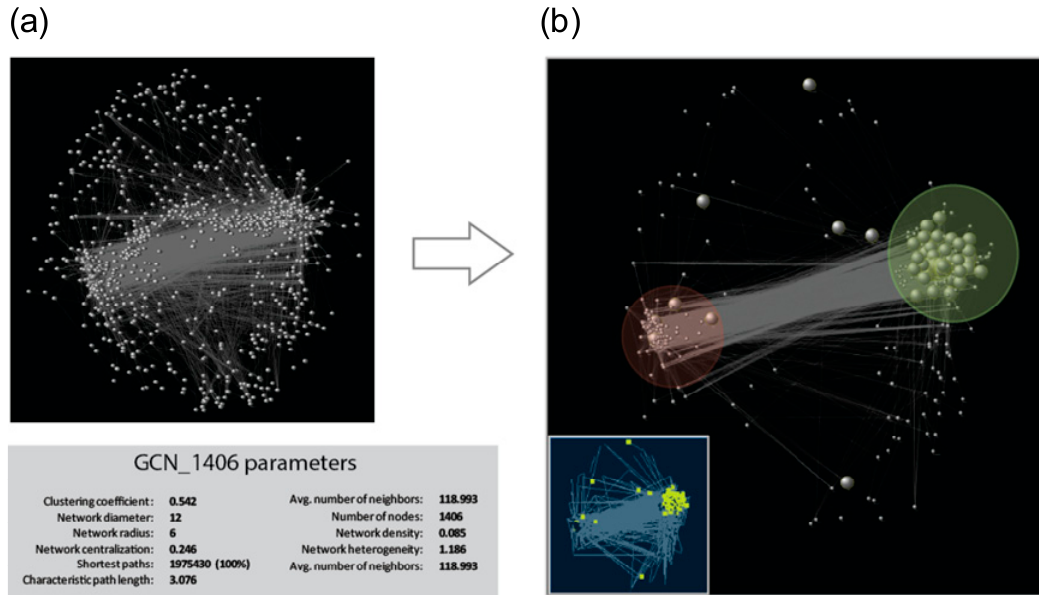
Figure 4. Gene co ‐ expression network identified for the TF ‐ PHOTO genes. ( a ) Global co ‐ expression network and GCN parameters, grey vertices (genes) are connected by an edge if a predefined association between vertices pairs is determined and ( b ) cluster three (in the light green circle) and cluster six (in the light red circle) subnetworks. Bigger grey dots in the big picture, and yellow dots in the smaller picture, represent photosynthesis pathway genes at the core of the TF ‐ PHOTO main global network.